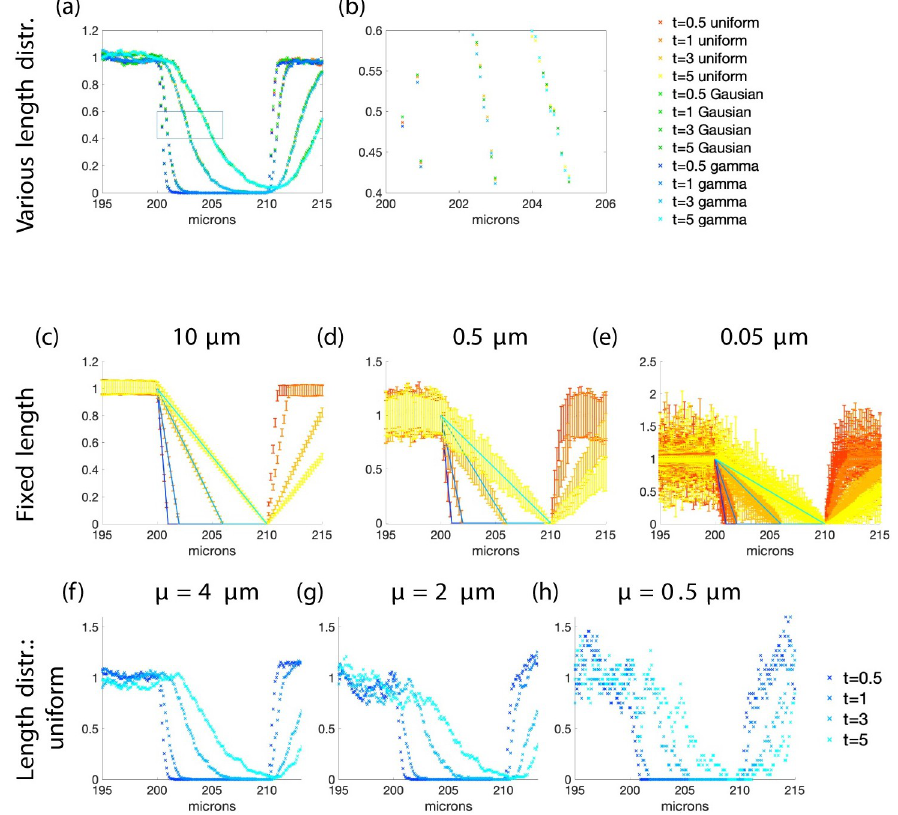
Fig 5. Impact of length distributions on FRAP intensity profile curve data (type 1). This figure compares the simulated results with random velocity and different length distributions. In panel (a) the type of length distribution changes, in panels (c)-(e) the length changes, and in (f)-(h) the mean length changes. Panel (b) is a blowup of the boxed region in panel (a). In panel (a) the average length for all distributions is 10 microns and for the Gaussian and gamma distributions the standard deviation is 0.2. In panels (c)-(e) the solid curves are plots of scaled Eq (5) such that k f k 1 = 1 and the error bars are type 1 simulated results. The length of the error line is twice the standard deviation of the 50 realizations centered at the average of the realizations. The curves and error bars in (c)-(e) are profiles at times 0.5 (blue and red), 1 (light blue and orange), 3 (lighter blue and light orange), and 5 minutes (cyan and yellow). The y axis is fluorescence intensity (a.u.) in all panels. Length : (a)—varied distributions, (c)-(e)—fixed, (f)-(h)—uniform. Velocity : (a),(b), (f)-(h) gamma μ = 1, σ = 0.25; (c)-(e)—uniform on interval [0,